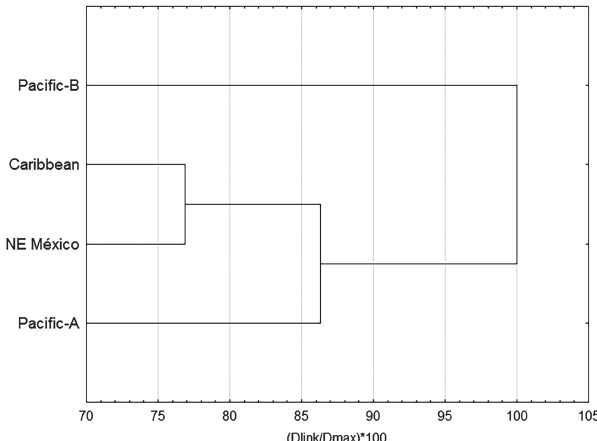
Fig. 4. Phenogram resulting from cluster analysis based on squared Mahalanobis distances resulting from the Discriminant Function Analysis of linear body